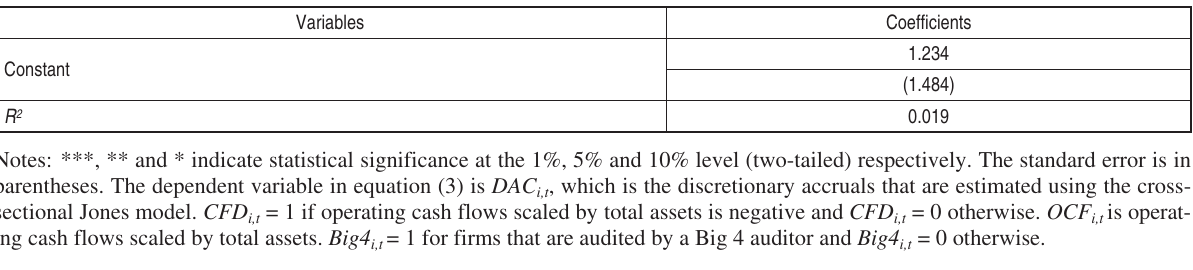
Table 3 (cont.). Conservatism and Big 4 auditing (equation 3)